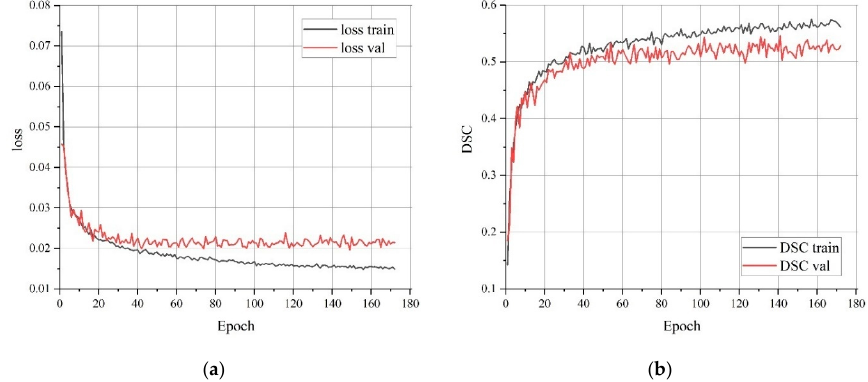
Figure 6. Loss function ( a ) and 𝐷𝑆𝐶 metric ( b ) when training model